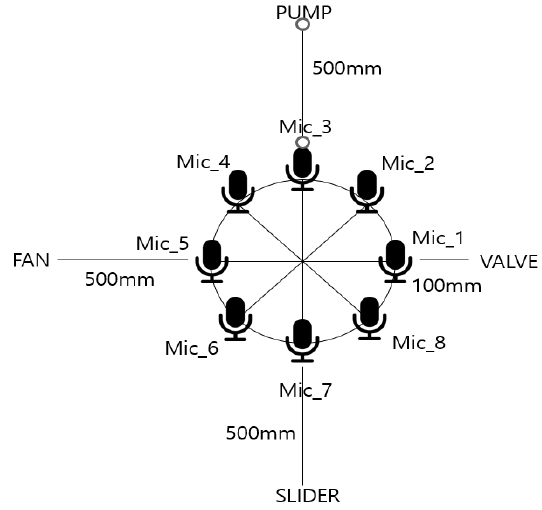
Figure 14. Data collecting environment for the MIMII dataset.